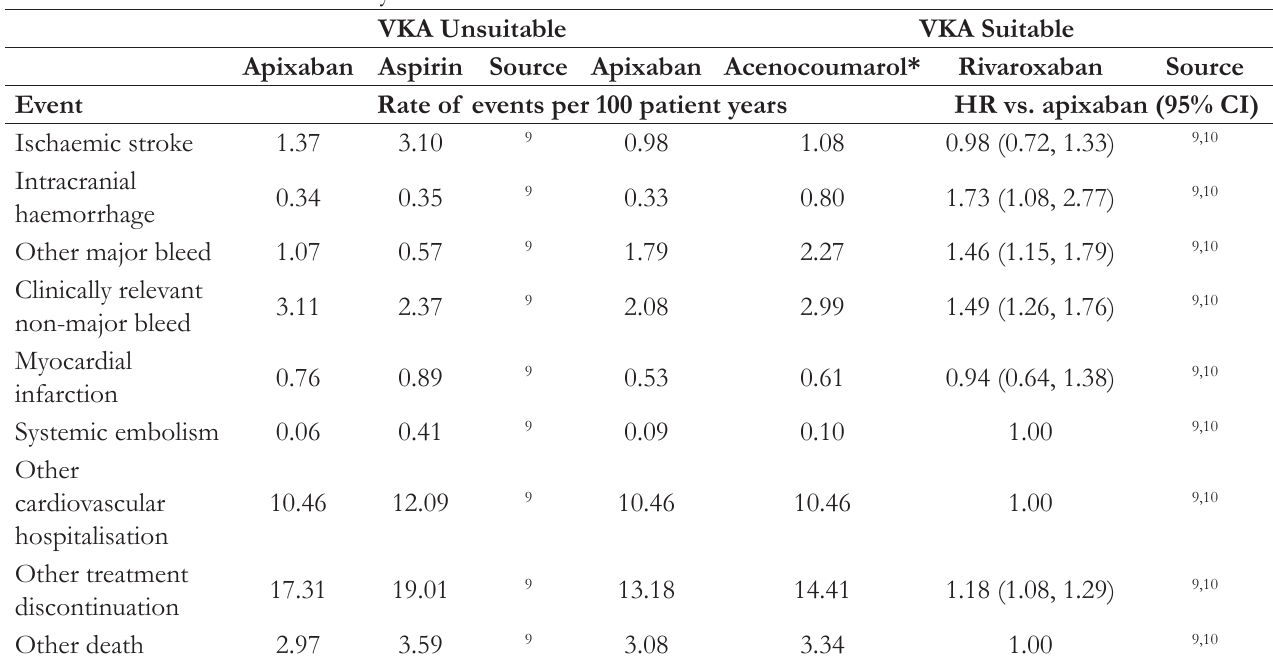
Table 2. Clinical Event Rates by